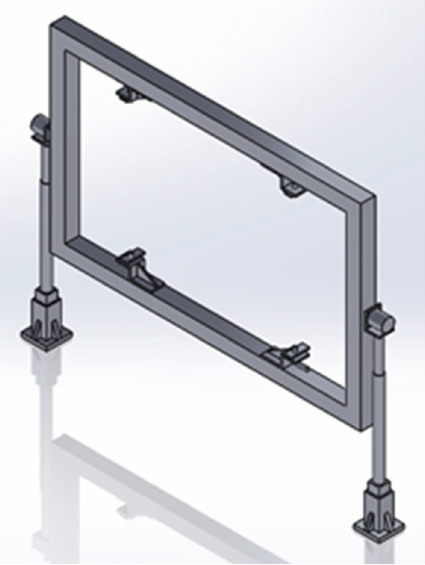
Figure 3: The design for fixtures for aircraft outer skin door drilling.